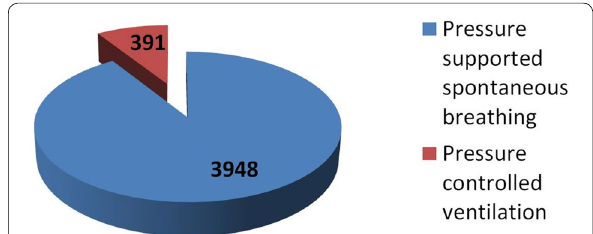
Fig. 3 Respirator mode during prone positioning (cumulative